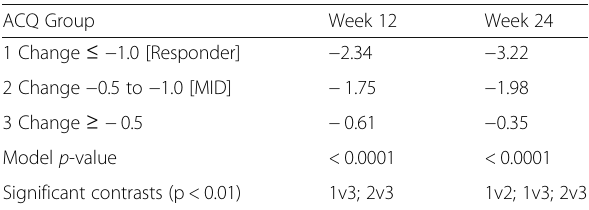
Table 5 Changes in ASD Symptomatic Days in a 7-Day Period by ACQ Change Groups at Weeks 12 and 24